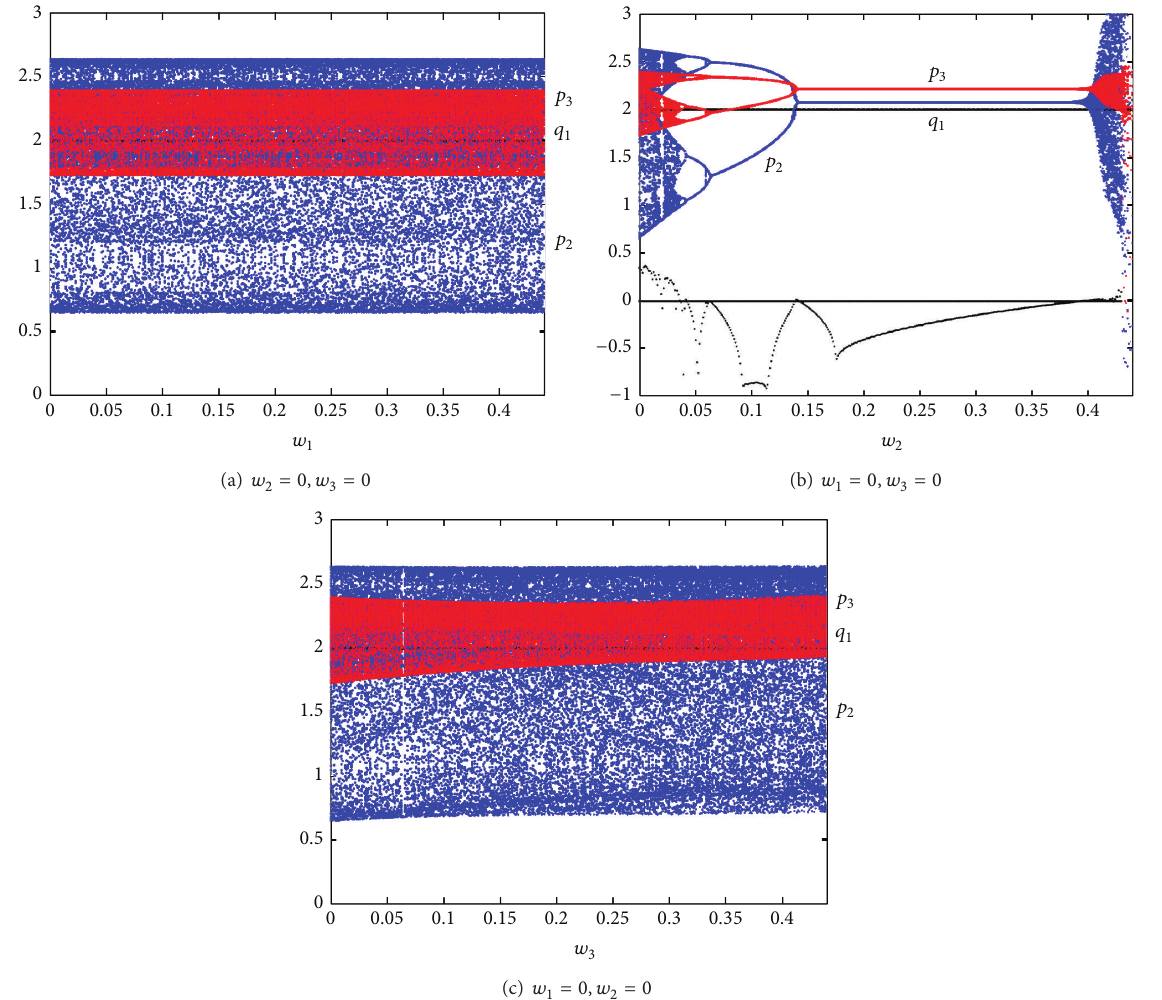
Figure 15: The bifurcation diagram and the corresponding largest Lyapunov exponent of the delayed system (25).